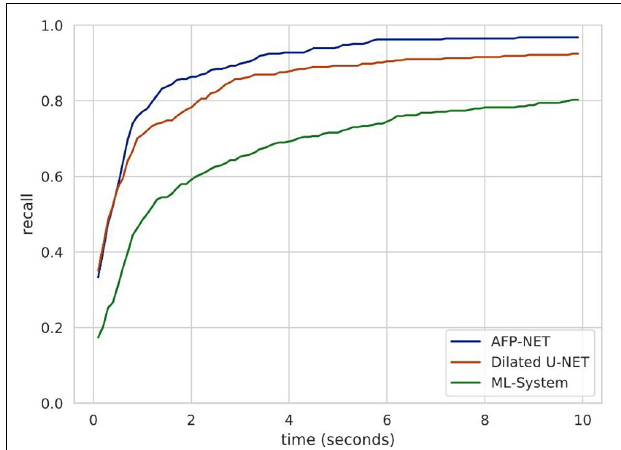
FIGURE 4 | Speed analysis of polyp identification in a DeFrame system from a full-length video perspective. Recall is a function of time for different models to find a polyp. Algorithm B (based on AFP-NET) can be used to detect more than 84% of polyps within the first 2 s when they appear in the view field, while the entire system can be used to detect more than 80% of polyps within the first 10 s.